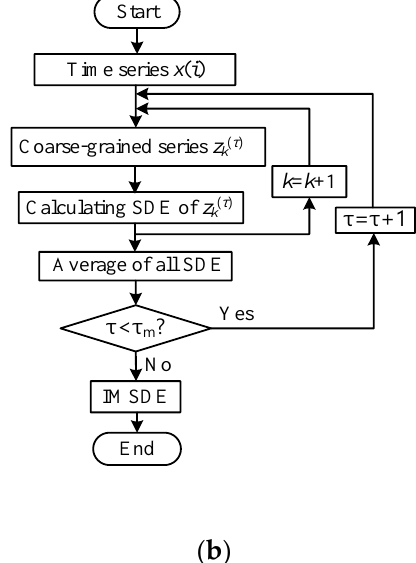
Figure A1. The improved coarse-grained procedure with data slipping operation.